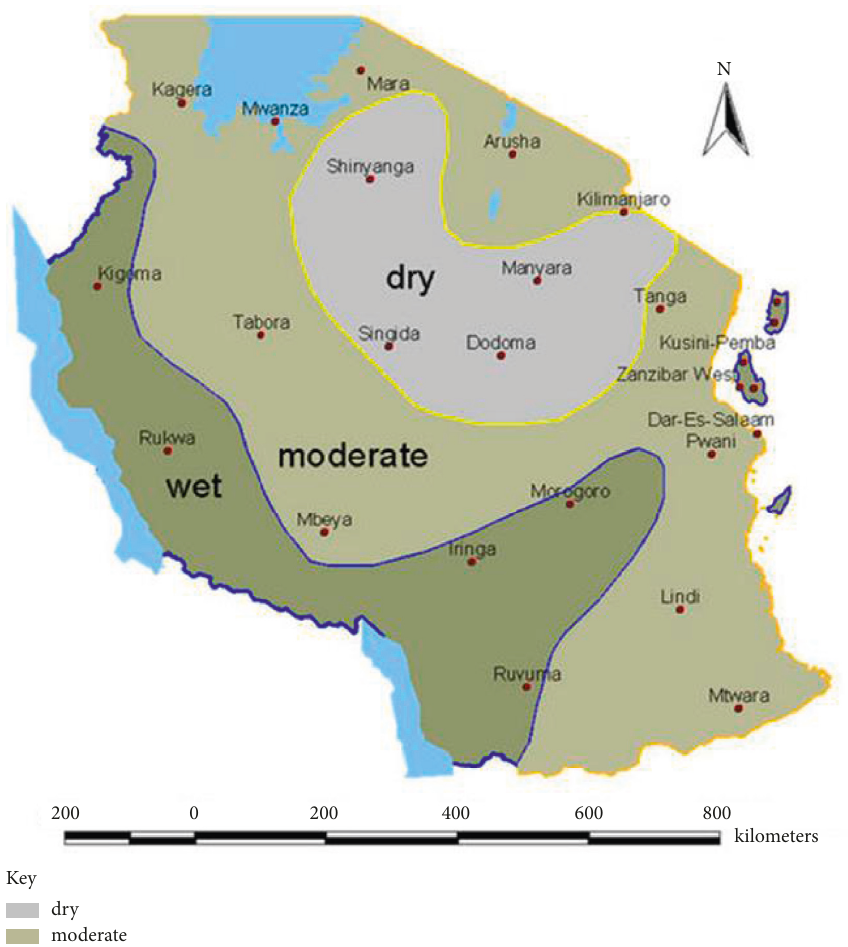
Figure 1: Map of Tanzania showing the location of Mtwara, Morogoro, and Dodoma and the main climate zones (source